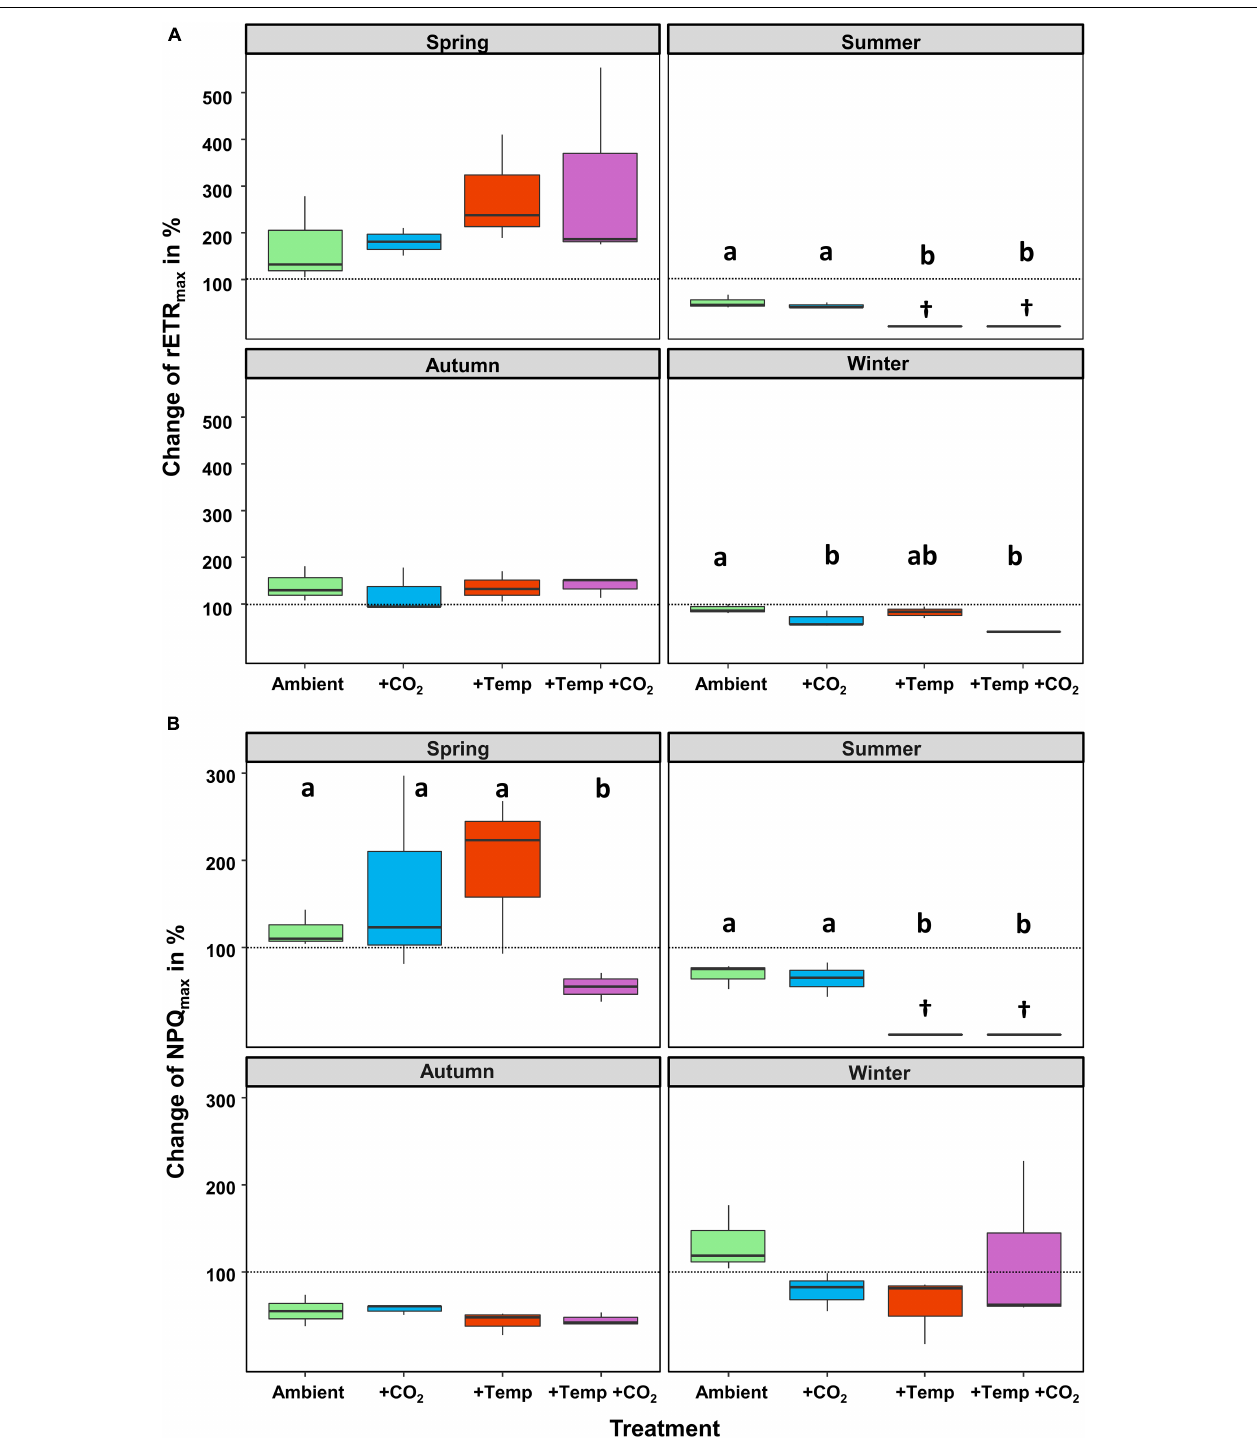
FIGURE 1 | Relative changes (as %) between the initial and final state of each experiment. (A) Maximum relative electron transport rate (rETR max ) and (B) maximum non-photochemical quenching (NPQ max ) of Fucus vesiculosus during experiments in the Kiel Outdoor Benthocosms with various temperature and pCO 2 conditions over different seasons; dashed line represent no change, values above 100% mean higher rETR or NPQ values at the end of the experiment. Seasons: spring: April